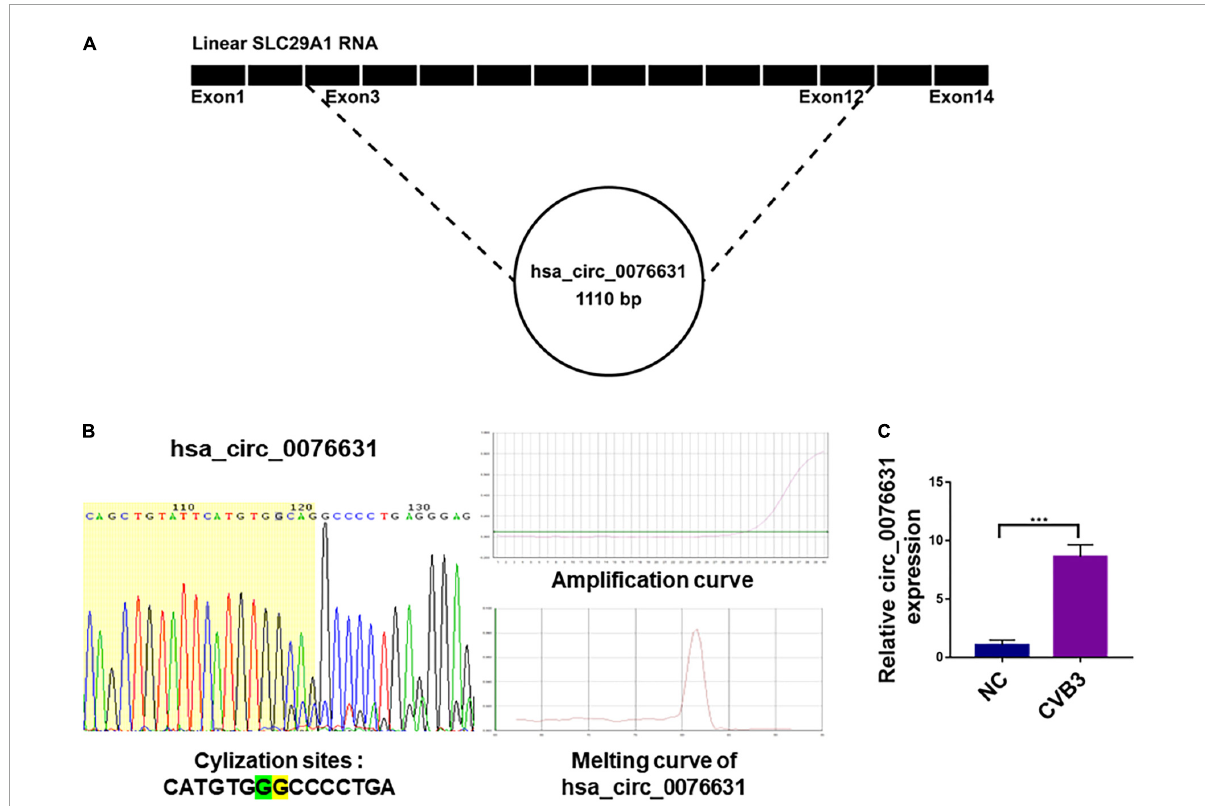
FIGURE1 The source of circ_0076631 and association with CVB3 infection. (A) The genomic location of circ_0076631 in the transcript of SLC29A1 gene. (B) Ring formation by circ_0076631 was performed on the basis of the amplification curve and dissolution curve, which are shown. (C) HeLa cells were infected with CVB3 (MOI = 10) and incubated for 6 h. Circ_0076631 levels were analyzed by RT-qPCR. n = 3, *** P < 0.01.